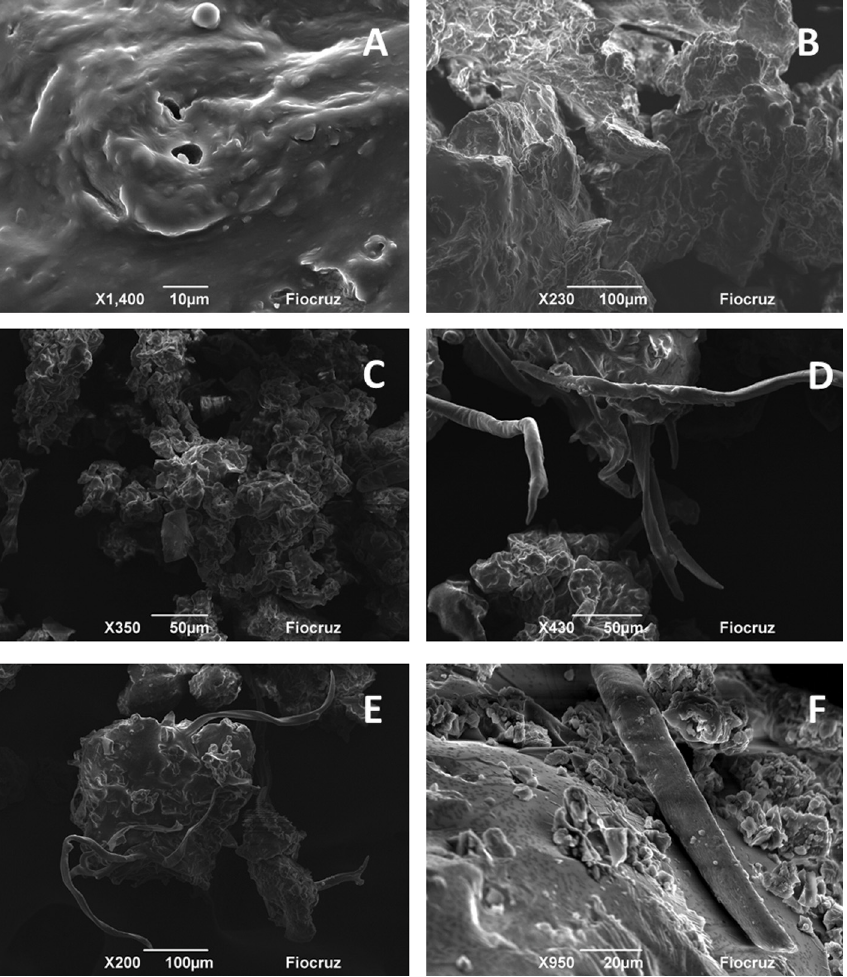
Fig 2. Images obtained by Scanning electron microscopy (SEM) for propolis samples. A – RSE; B – RAL; C –